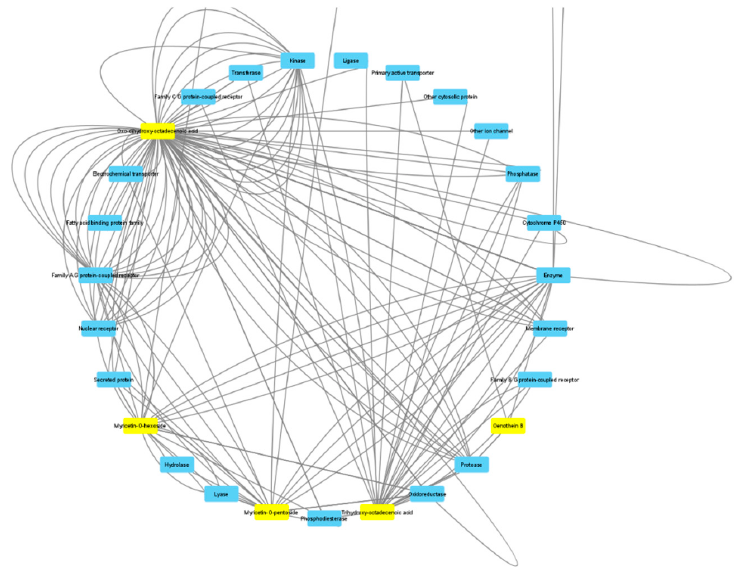
Figure 2. Target analysis of components underlying the putative interactions of oenothein B, myricetins, oxo-dihydroxy-octadecenoic acid, and trihydroxy-octadecenoic acid with a wide number of proteins, among which are oxidoreductases and secreted proteins, which are also involved in oxidative stress and inflammation. Proteins targeted by extracts were predicted using the bioin- formatics platform SwissTargetPrediction, and the network pharmacology analysis was conducted through the software Cytoscape (Version 3.8).